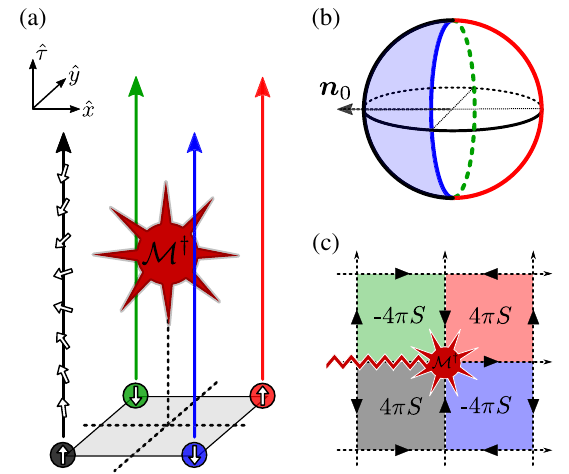
FIG. 13. (a) The monopole operator inserted in the Euclidean spacetime. White arrows represent spin directions. The imaginary time trajectory of each spin is represented by a colored line. White arrows in the black trajectory show how the direction of the spin changes along the imaginary time when the monopole is Þ sweeps through the imaginary inserted. (b) The solid angle ω ð n r time with respect to the reference vector n 0 . (c) The dual lattice where a monopole operator resides. Here, plaquette centers correspond to the spin sites. The lattice spin acts as an alternating flux pattern ð − 1 Þ r x þ r y 4 π S for monopoles. The hopping amplitude along each black arrow gives a phase factor of e i π S ¼ i in our S ¼ 1 = 2